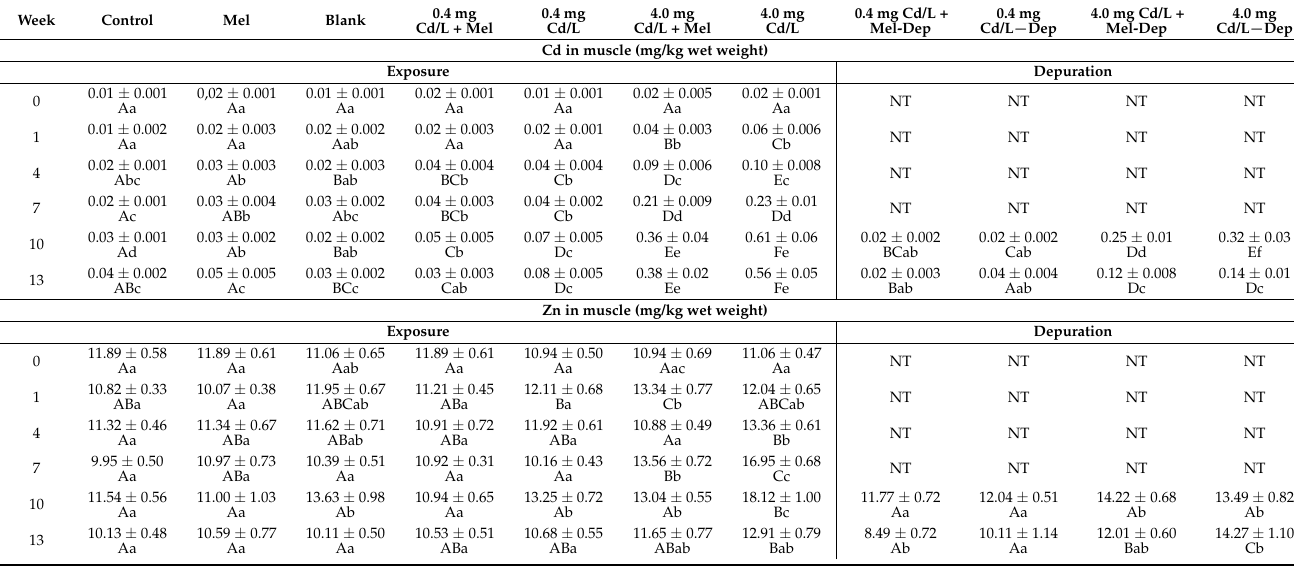
Table 3. Comparison of Cd and Zn levels (mg/kg ww) in the muscles of female Prussian carp during 13 weeks of fish exposure to different doses of cadmium and 6 weeks